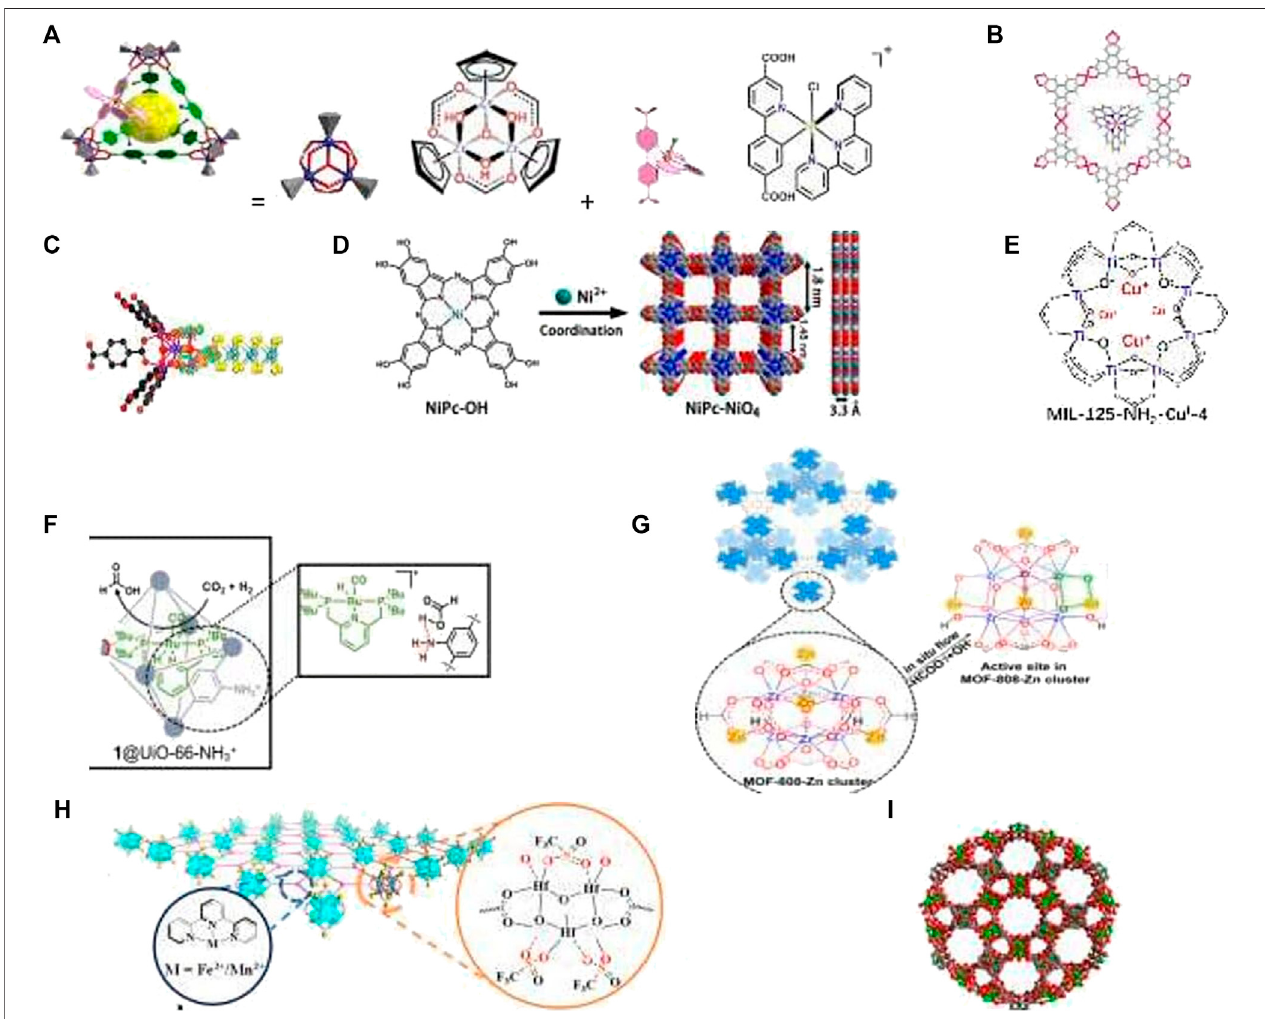
FIGURE 3 | MC for CO 2 transformations: (A) MOC decorated with an Ir(III) complex for CO 2 photoreduction. (B) Electrostatic attraction-driven assembly of MOF with a photosensitizer for photocatalytic CO 2 reduction to CO (Huang et al, 2021). (C) Hierarchically porous d-UiO-66/MoS 2 for selective conversion of CO 2 with 1 – 120 into CH 3 COOH (Yu T. et al, 2021). (D) Conductive two-dimensional phthalocyanine-based MOF nanosheets linked by nickel-catecholate for CO 2 electroreduction. (E) MultiplecuprouscenterssupportedonTi-MOFforCO 2 hydrogenationtoethylene(Zengetal,2021). (F) MulticomponentcatalystsystembasedonMOFUiO-66for the hydrogenation of carbon dioxide to methanol (Rayder et al, 2021). (G) MOF-808-Zn catalyst for CO 2 hydrogenation (Zhang H. et al, 2021). (H) Bifunctional Metal- Organic Layers for tandem catalytic transformations using molecular oxygen and carbon dioxide (Shi et al, 2021). (I) COF assembled from 12-nuclear [Cu 12 ] nanocages with two types nanotubular channels for a catalysis the cycloaddition of CO 2 to various epoxides (Wang K. et al, 2021).